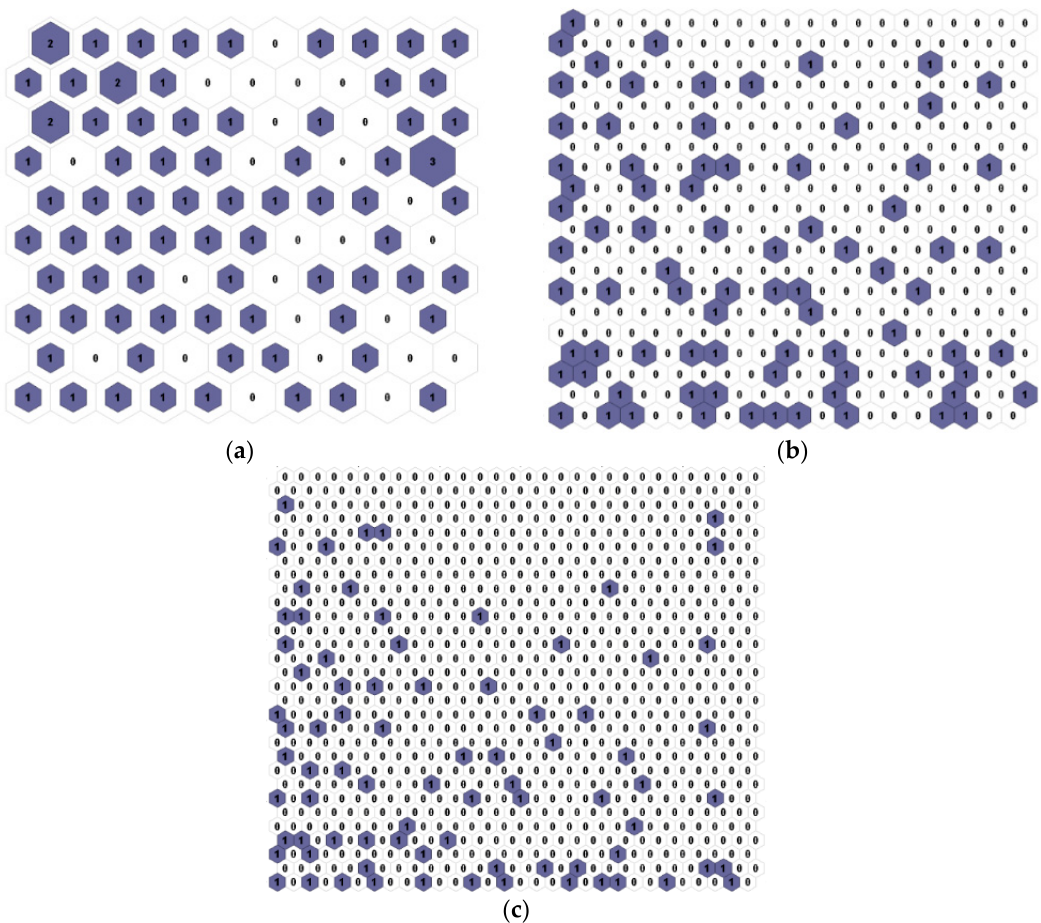
Figure 4. Map of Hits for the three evaluated scenarios: ( a ) Type-1 with 100 neurons and 13 groups, ( b ) Type-2 with 400 neurons and 47 groups, and ( c ) Type-3 with 900 neurons and 56 groups.